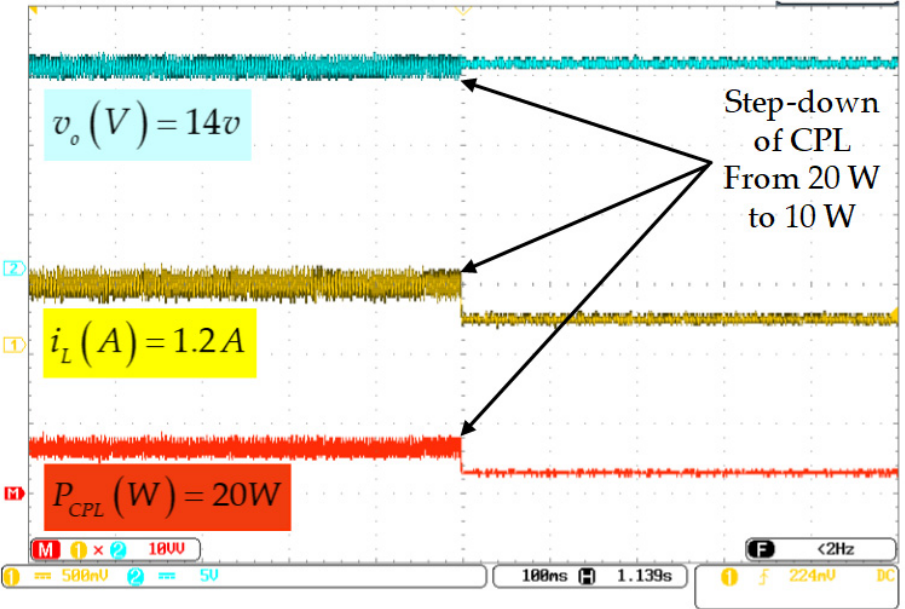
Figure 17. Experimental results for decreased power demand of the CPL from 20 W to 10 W.